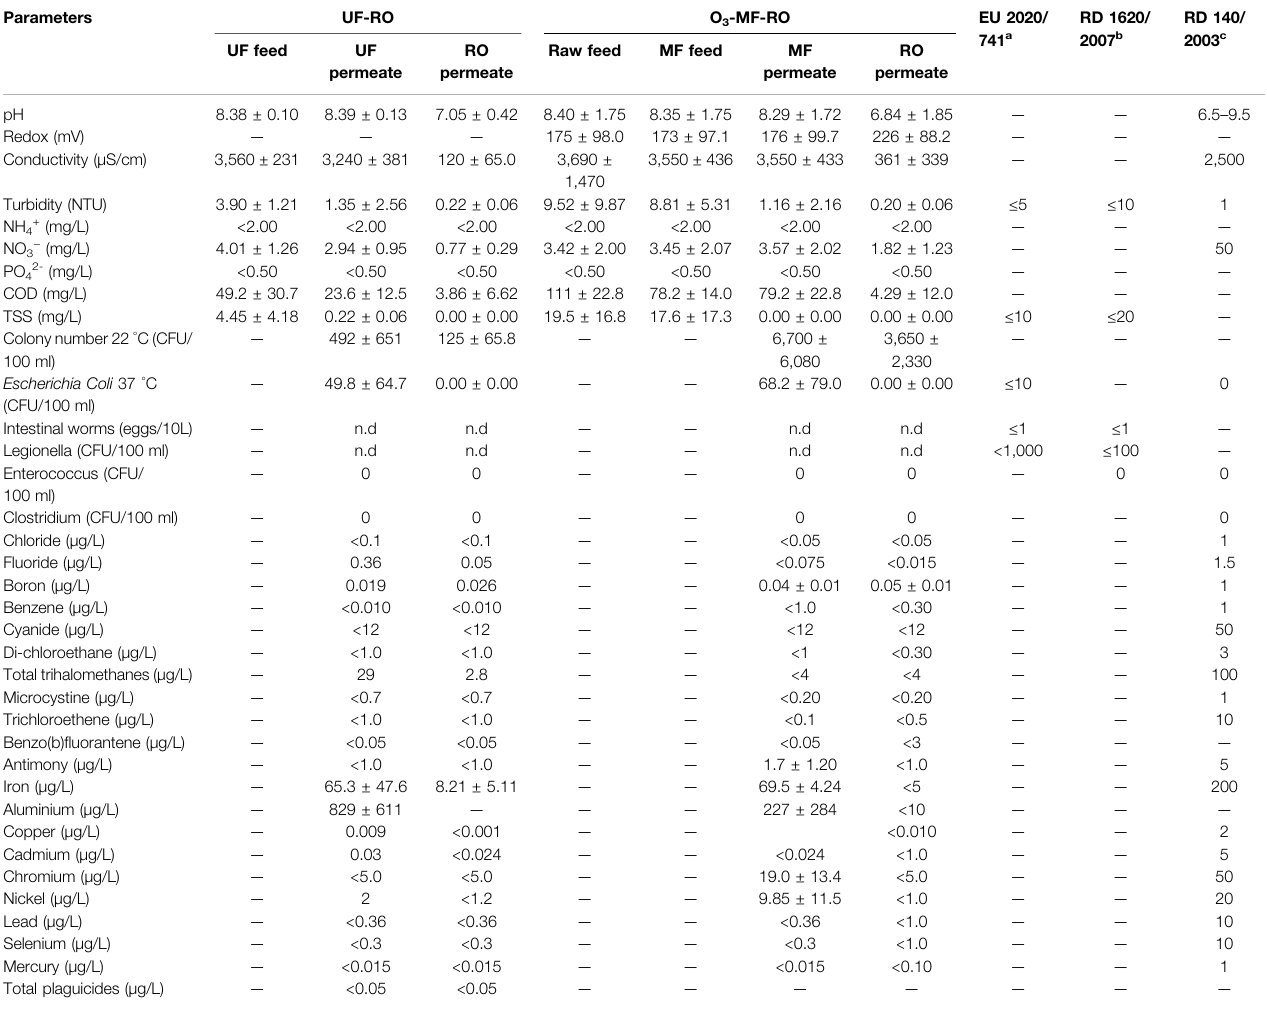
TABLE 4 | Summary of results from the water quality analyses of the main streams resulted from the main processes of both treatment plants.